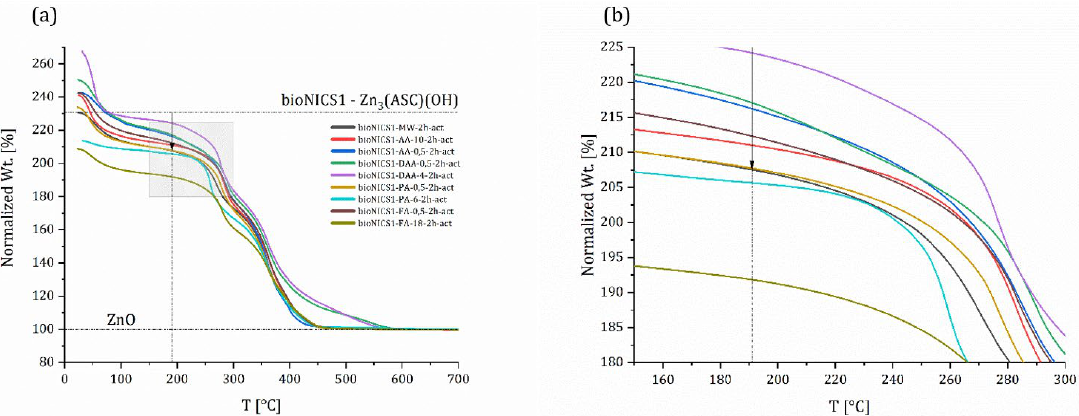
Figure 5. Comparison of thermogravimetric curves of selected, activated bioNICS1 materials crystalized under microwave heating for 2 h ( a ). Grey rectangle is magnified and presented in ( b ), where the line and arrow are set to the 191 °C marking the start of degradation of the linker.